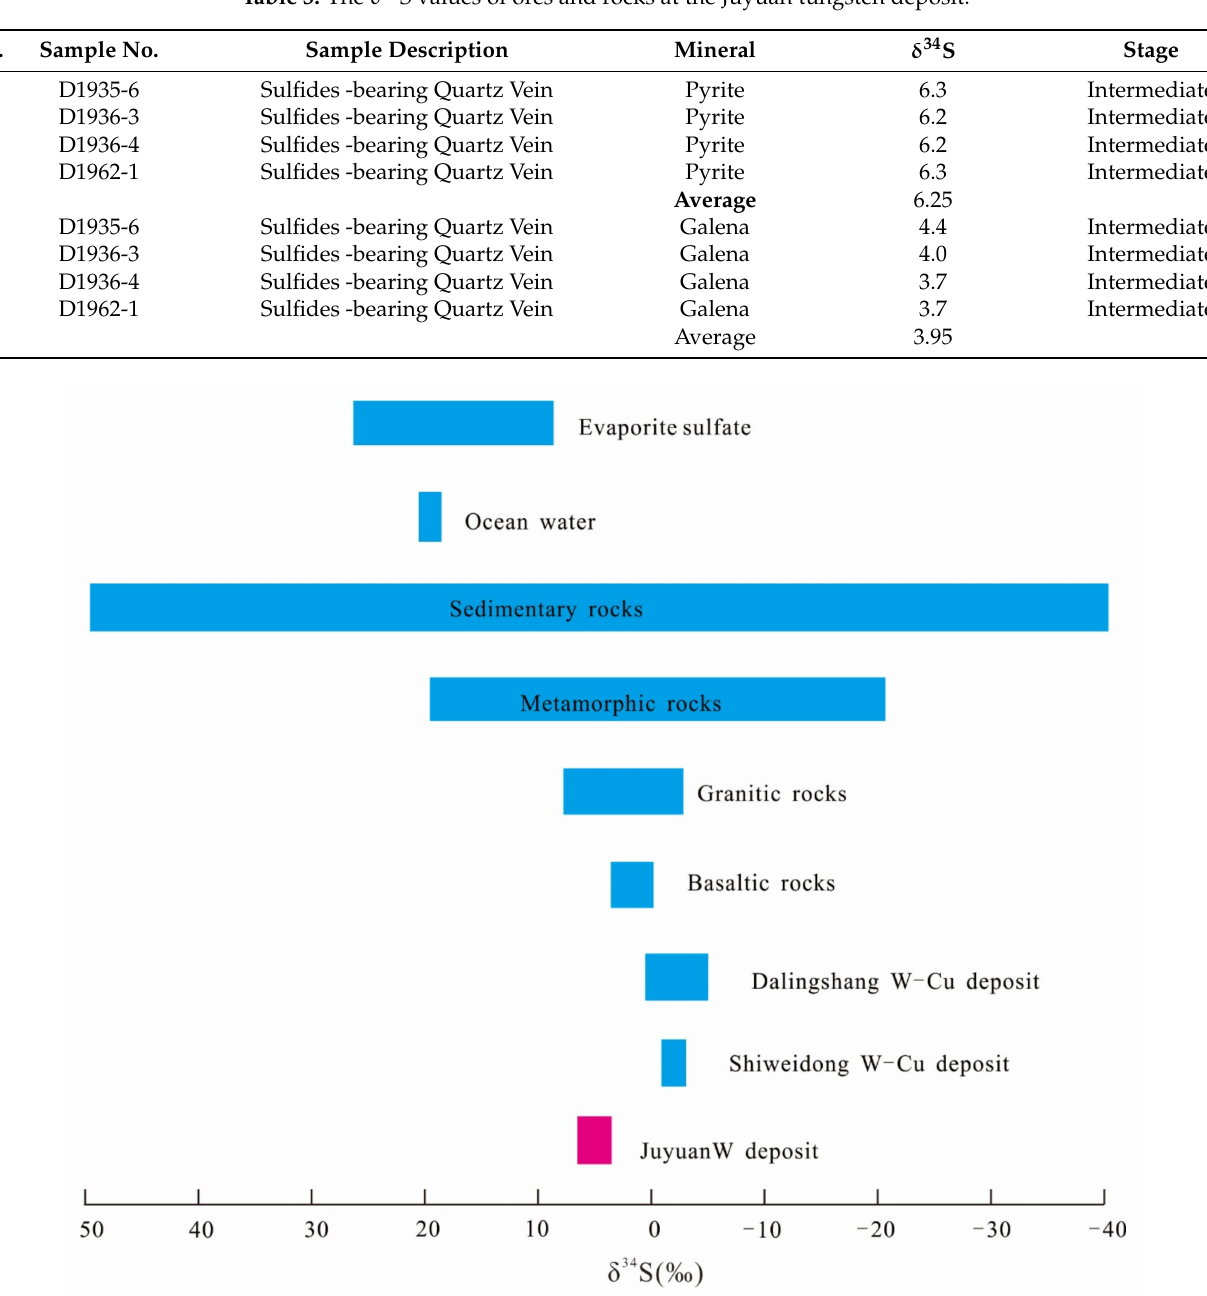
Figure 10. δ 34 S values of sulfides from the Juyuan deposit. Data of other deposits are presented in